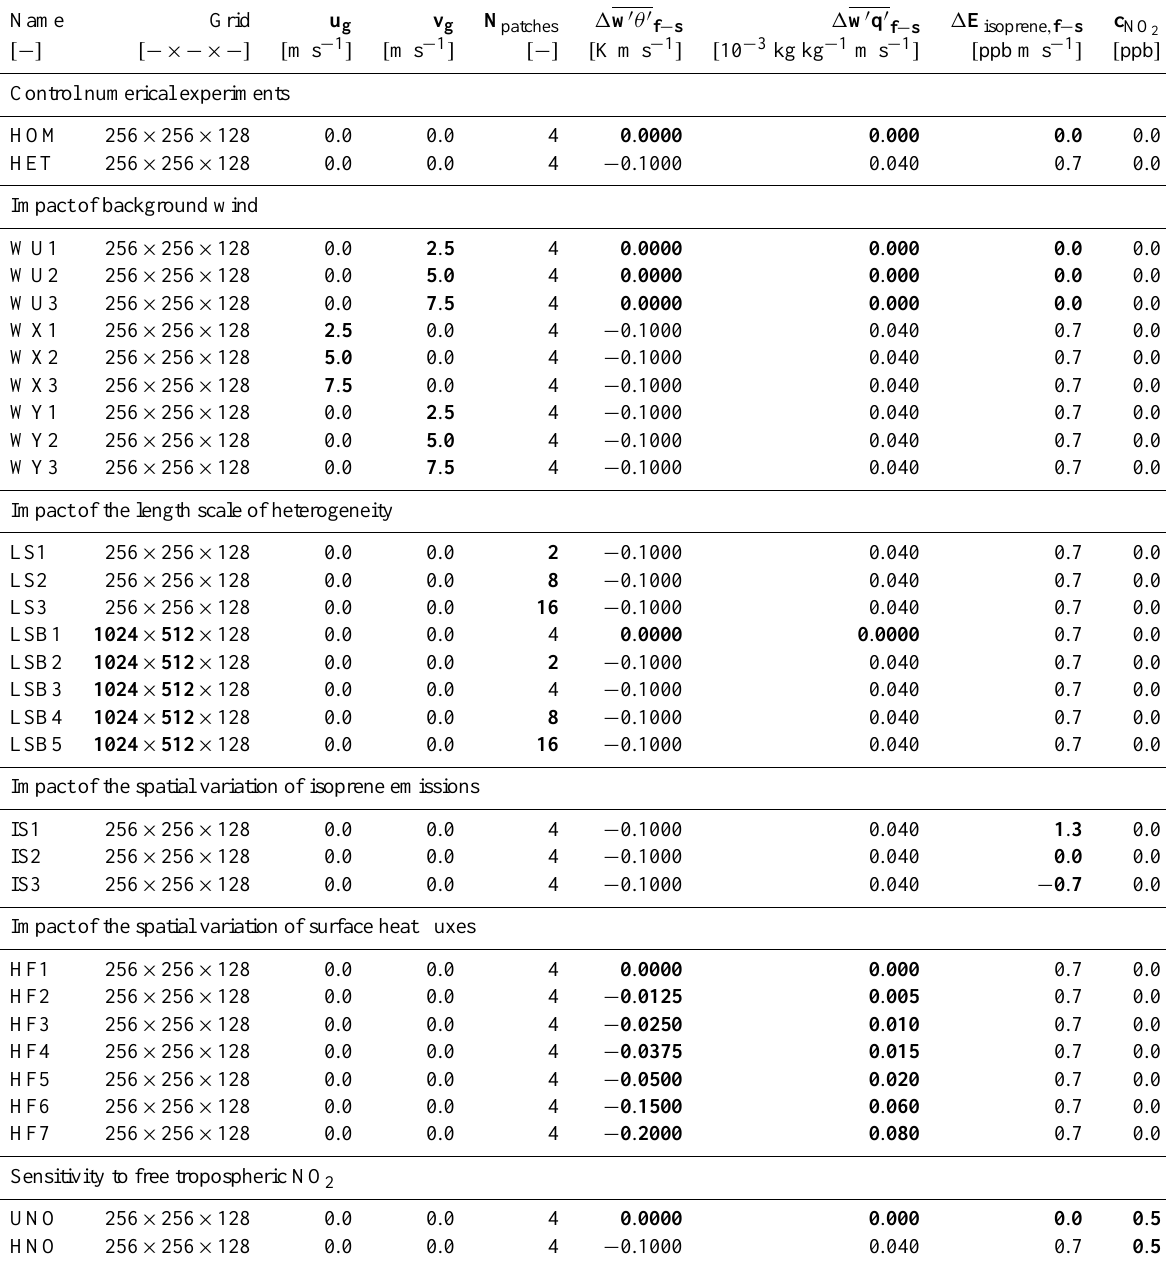
Table 3. Description of the different simulations. Variables not listed in this table are kept the same as the control cases treated in Sect. 2.2. u g and v g are the large scale background wind profiles. N patches represents the total number of patches in which the surface is divided in the x-direction. 1w 0 θ 0 f − s is the difference in kinematic heat flux over the forest patch, f , relative to the savannah patch, s , and 1w 0 q 0 f − s is the difference in kinematic moisture flux. 1E isoprene ,f − s represents the difference in isoprene emission between the forest and the savannah. c NO is the initial free tropospheric NO 2 concentration. The input variables that are altered with respect to the heterogeneous 2 control numerical experiment, HET, are printed in